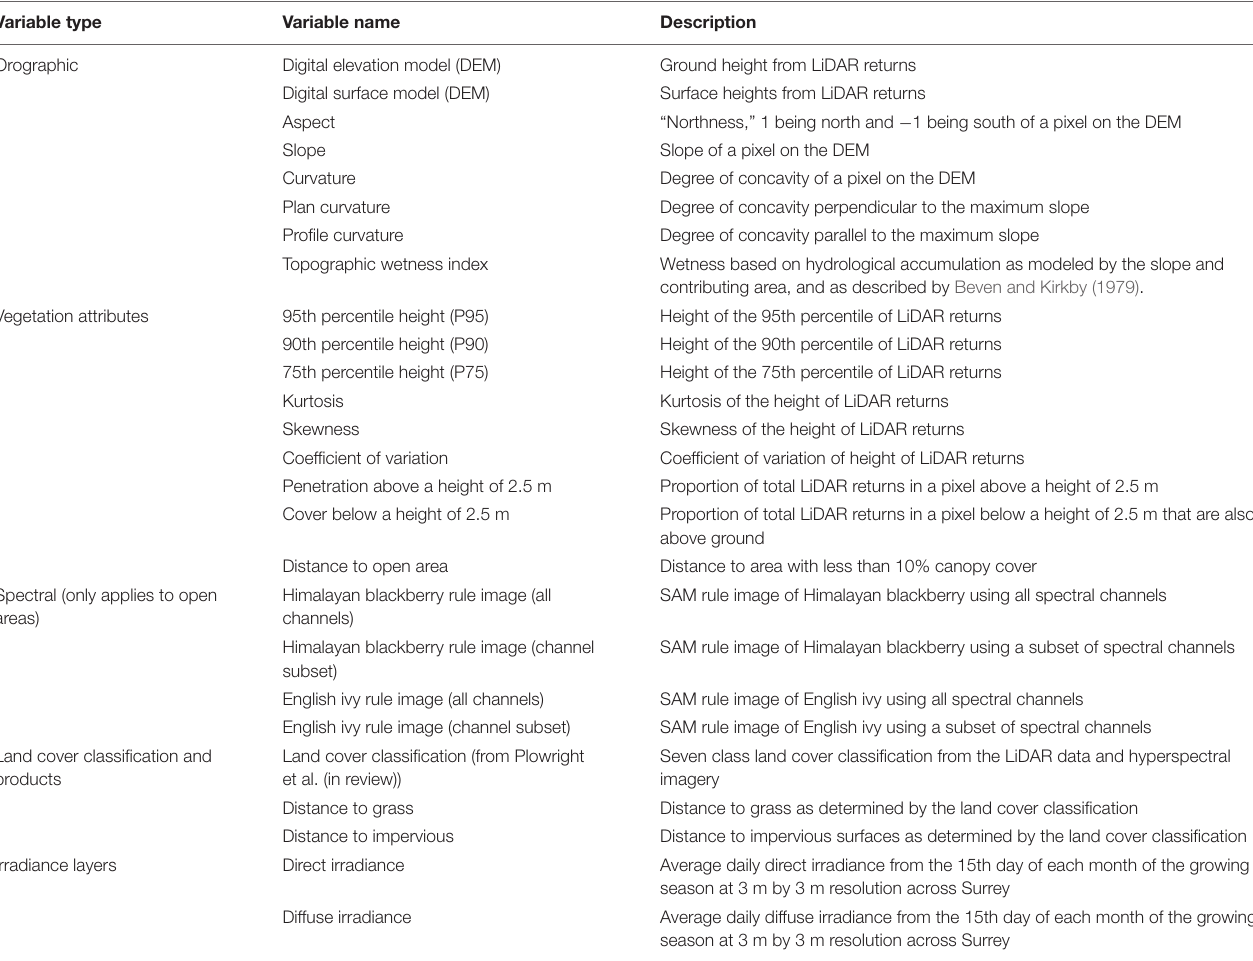
TABLE 1 | Variables used as inputs to the random forest models to detect Himalayan blackberry ( Rubus armeniacus ) and English ivy ( Hedera helix ) in Surrey, BC,